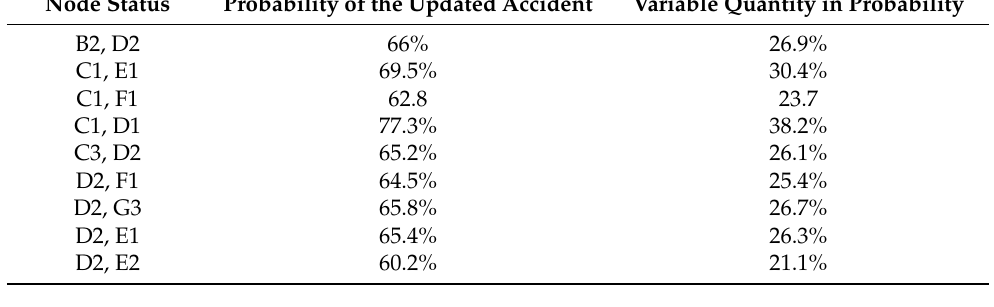
Figure 6. Accident prediction when the evidence variables are “G1 mild” and “D2 moderate”.